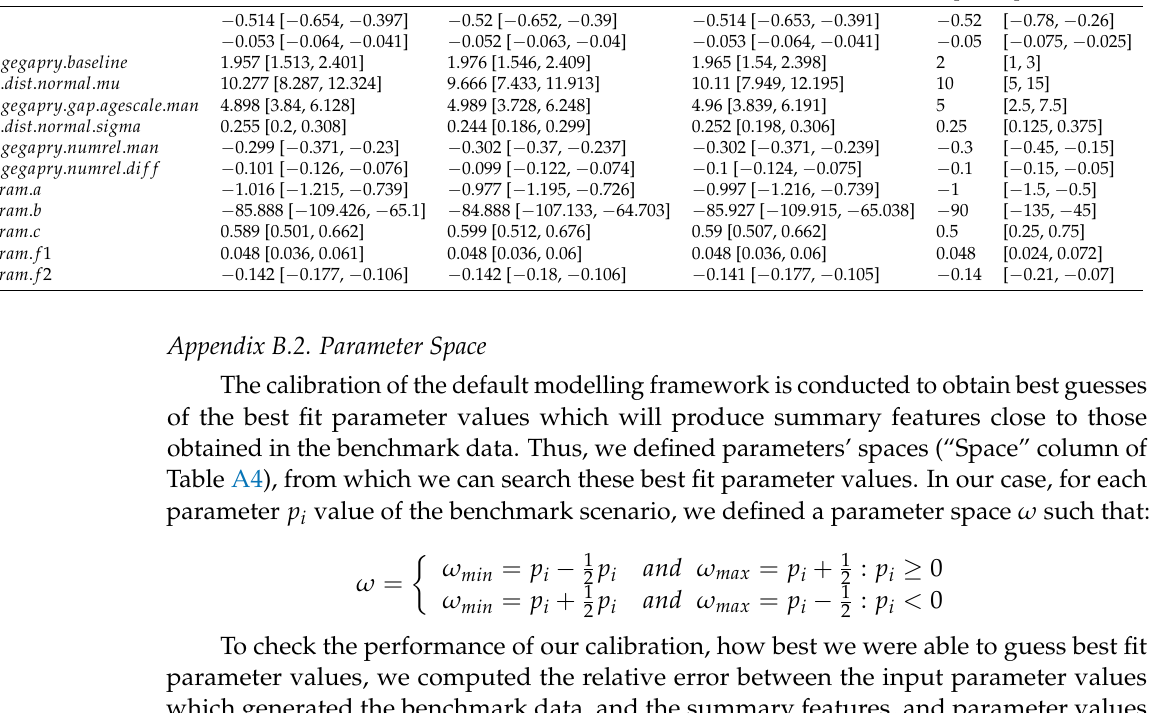
Table A4. Median values and inter-quantile range for retained parameter values during calibration with epidemiological and behavioural features (Calibration 1), phylogenetic tree features (Calibration 2), and combined features (Calibration 3); together with input values used to run the master model (benchmark data), and the search parameter space for calibration. Parameter Calibration 1 Calibration 2 Calibration 3 Input Space dissolution . alpha